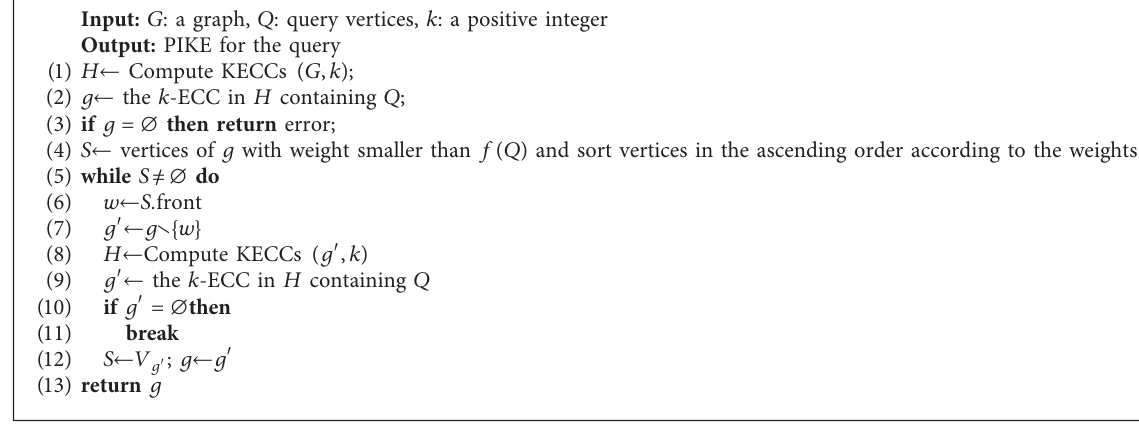
A LGORITHM 1: Baseline algorithm